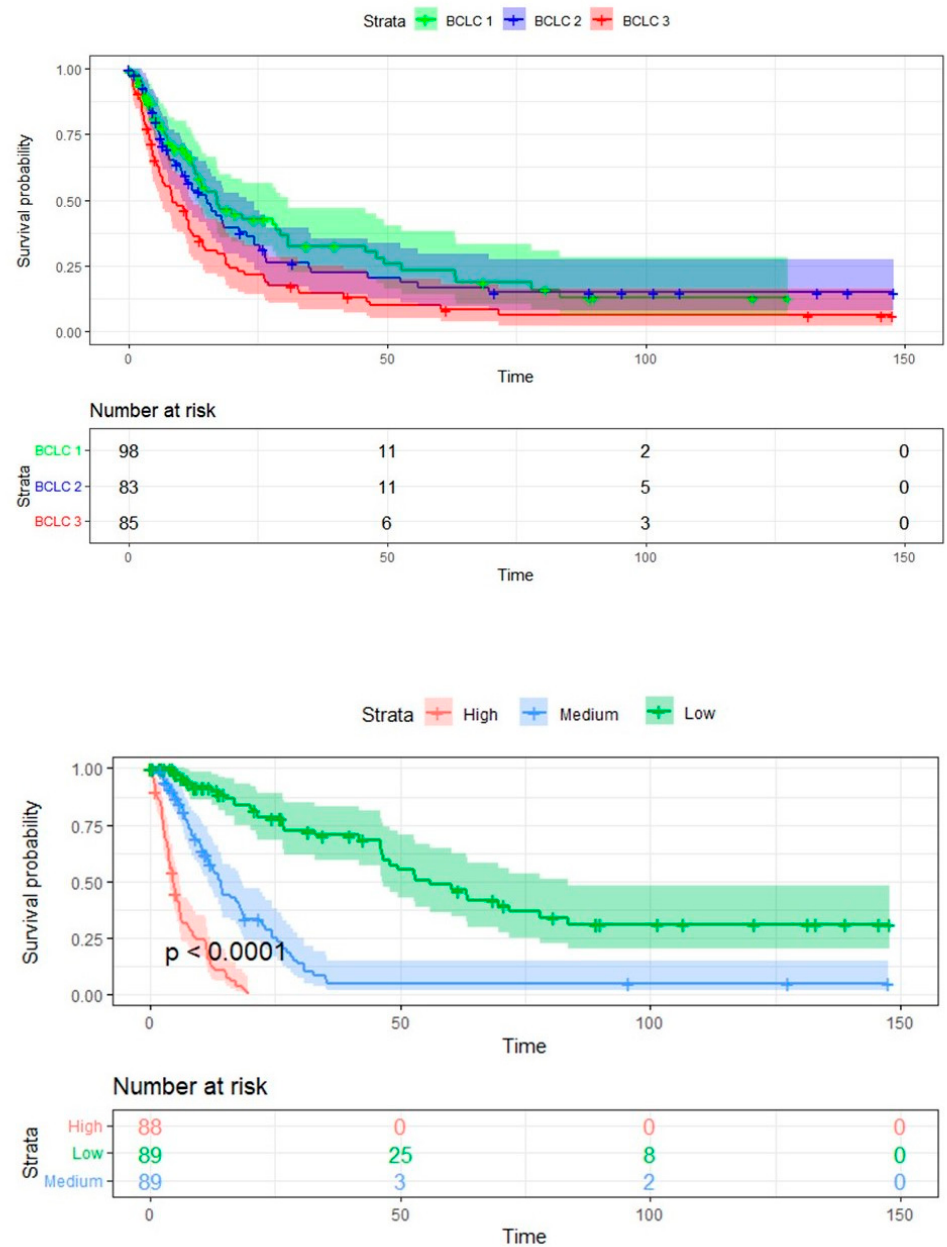
Figure 6. Above: Kaplan–Meier curve of the combined model, incorporating radiomics features and BCLC classification (BCLC 1 = 0-A, BCLC 2 = B, BCLC 3 = C-D) with its respective p value. Below: Kaplan–Meier curve of the radiomics classifier based on three categorical tertiles with its respective p value (low, medium, and high radiomics